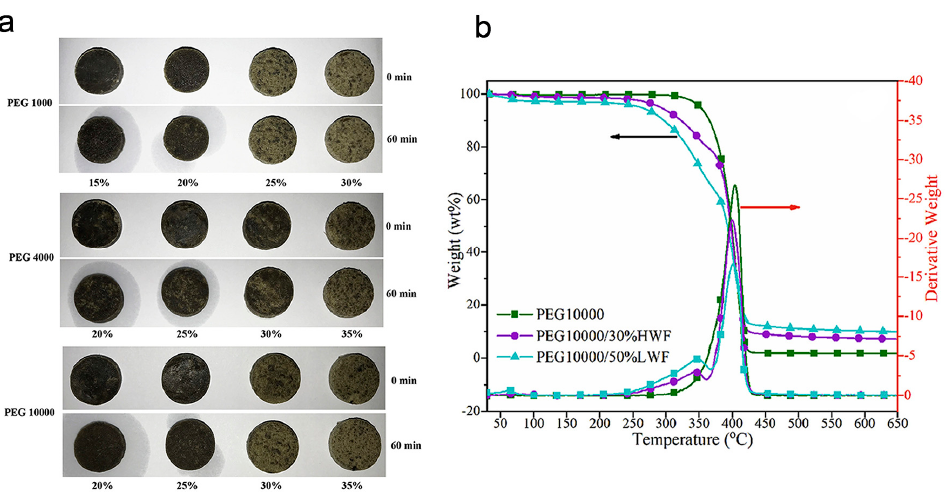
Figure 1. ( a ) Photographs of leakage test; ( b ) thermogravimetric and differential thermogravimetric analysis curves of PEG/HWF shape-stabilized PCMs. HWF stands for high length-to-diameter ratios of wood flour and LWF stands for low length-to-diameter ratios of wood flour. Reproduced with permission from reference [34], copyright 2019, Elsevier B.V.